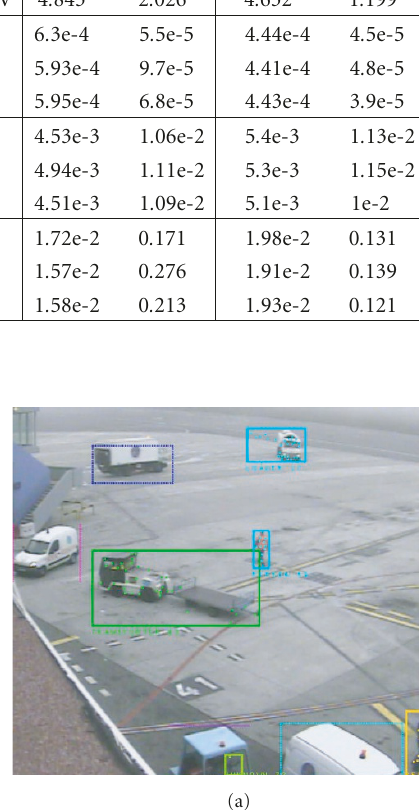
Figure 14: The results obtained from the local feature-based tracking algorithm. Image (a) has been chosen from S21-Cam7 and image (b) from